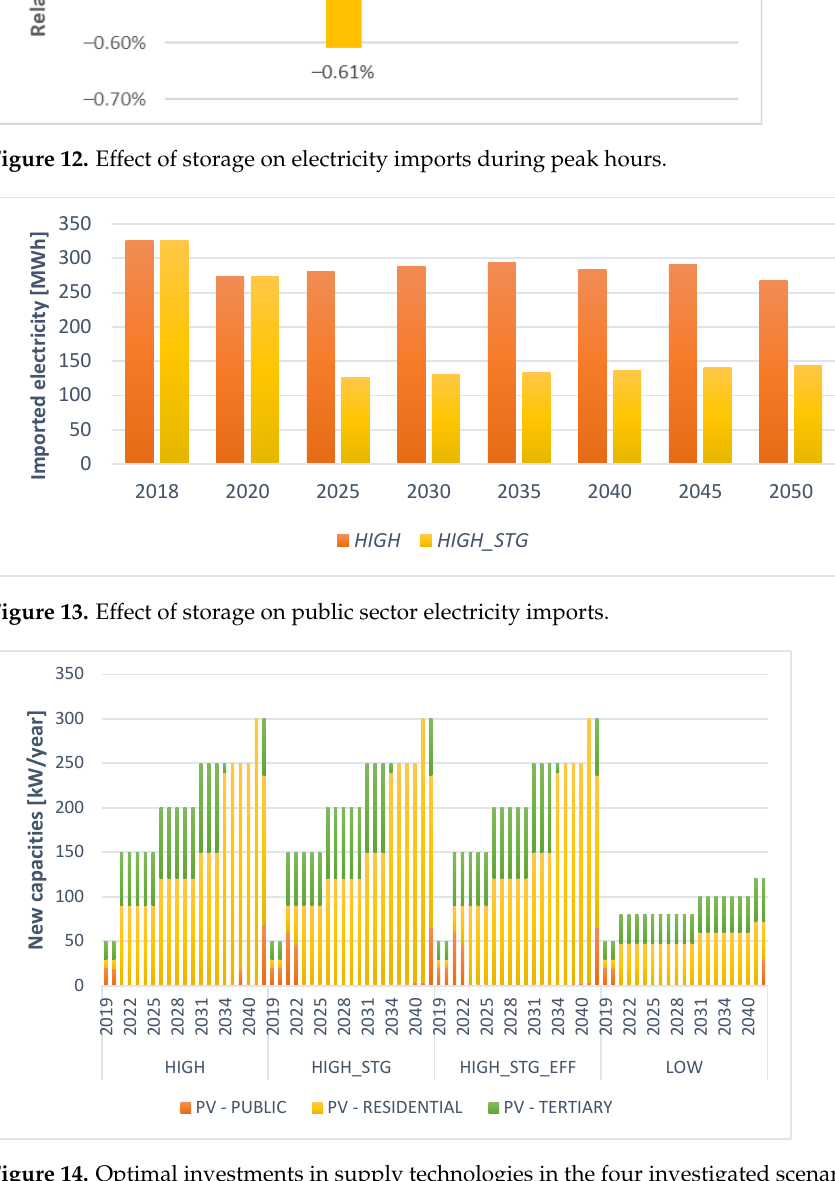
Figure 14. Optimal investments in supply technologies in the four investigated scenarios.